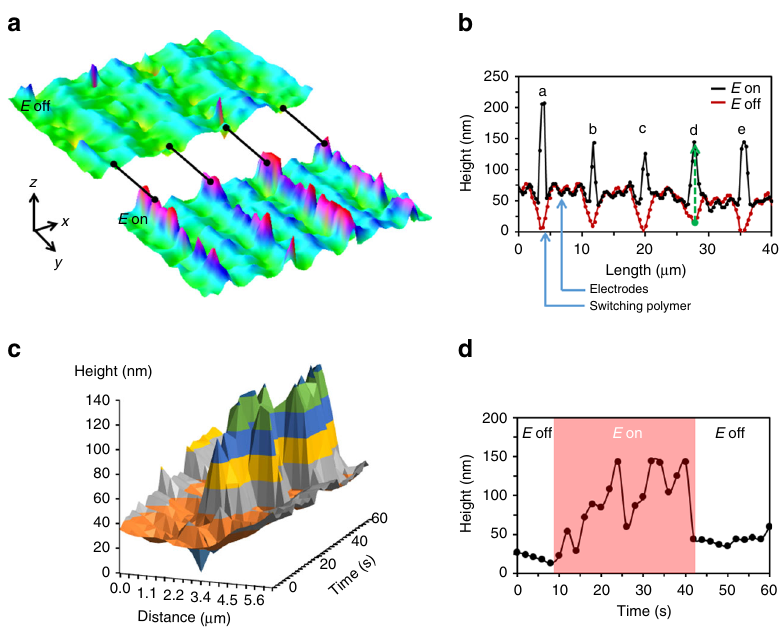
Fig. 2 Surface deformations under an electric fi eld. a 3D images of a coating on an electrode array in its initial state, and when the electric fi eld is on. b The corresponding cross-sectional height pro fi le of a measured in x-direction. The red curve gives the pro fi le in the fi eld-off state, with somewhat elevated areas over the electrodes. The black line is a snapshot measured during the fi eld-on state showing a protrusion of around 150 nm. The sample is activated at 41 °C under an electric fi eld strength of 7.5 V/ µ m at 900kHz. c Time evolution of pro fi le “ d ” in b from the initial to the activated state under a continuous AC electric fi eld. d The height change over time of the selected point marked green in pro fi le “ d ” of